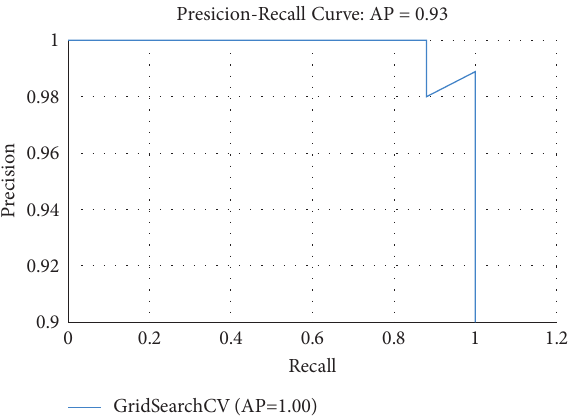
Figure 4: Precision-recall curve.